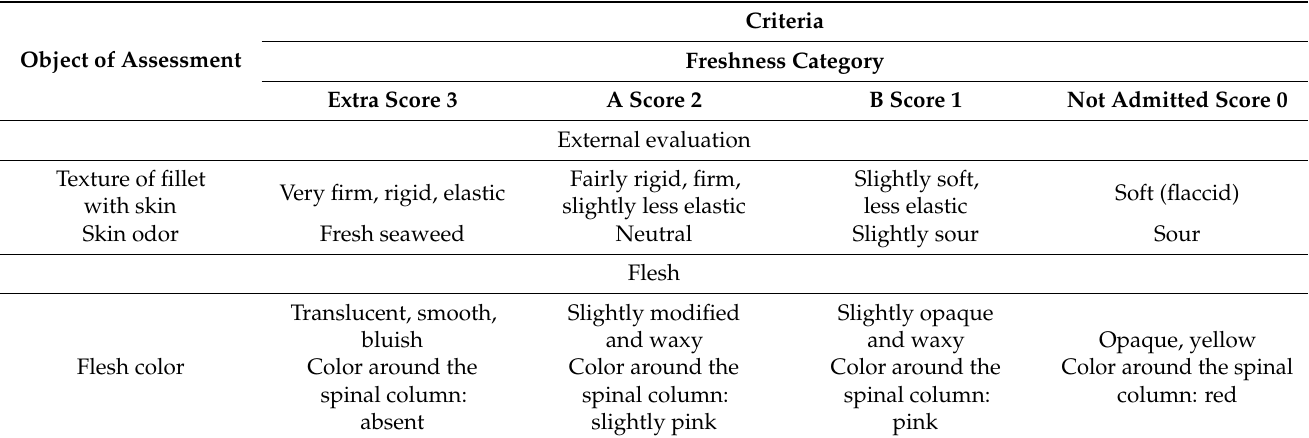
Table 1. Evaluation of the raw fillets with skin